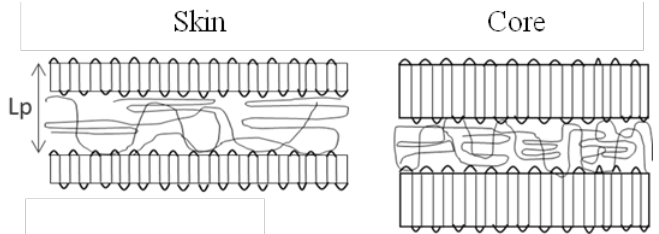
Figure 14. Possible lamellae organization in injection-molded PA66.